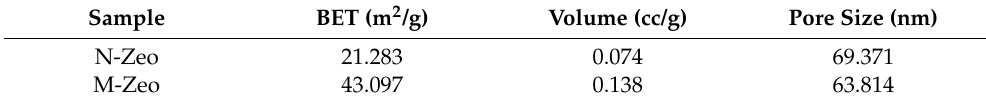
Table 1. The values of specific surface area, pore volume, and average pore size of N-Zeo and M-Zeo.